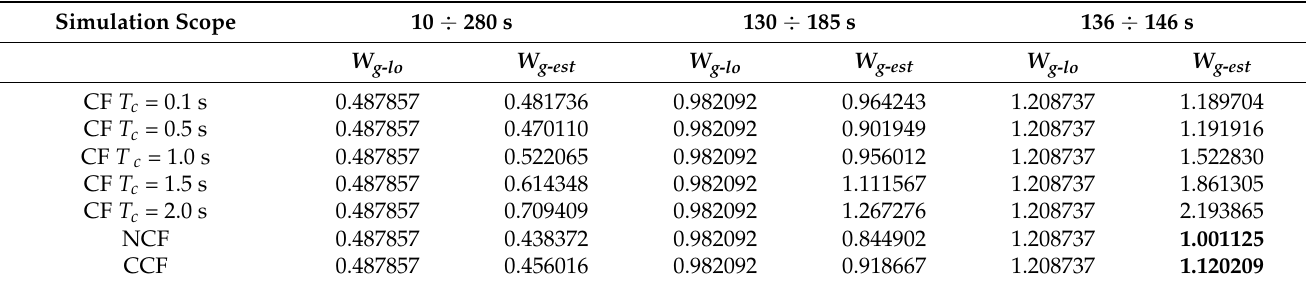
Table 4. The results of computation of performance indices for delay = 1.75